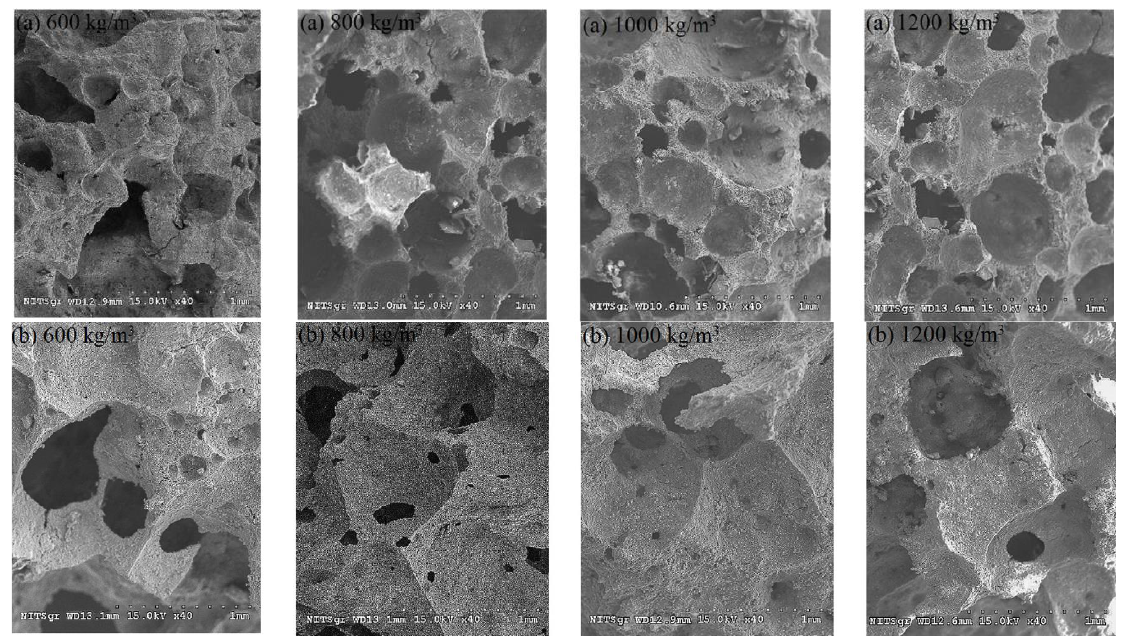
Figure 10. Microscopic images: ( a ) protein-based foam concrete, ( b ) synthetic-based foamed concrete. Reprinted/adapted with permission from Ref. [20]. 2021, Elsevier Science &Technology Journals.